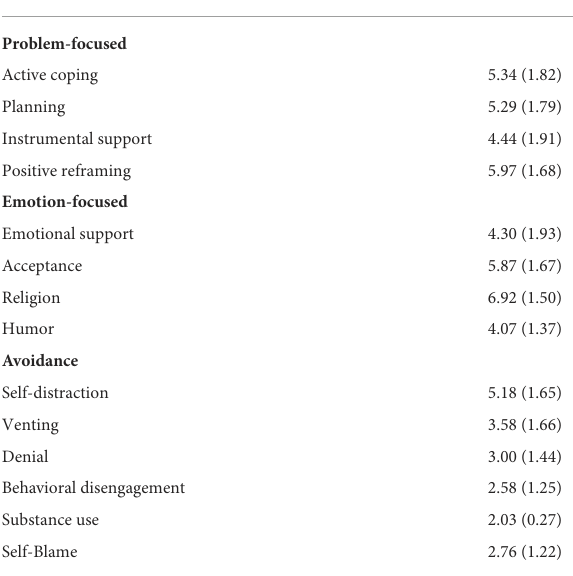
TABLE 2 Mean score and standard deviation of coping strategies among caregivers of patients with